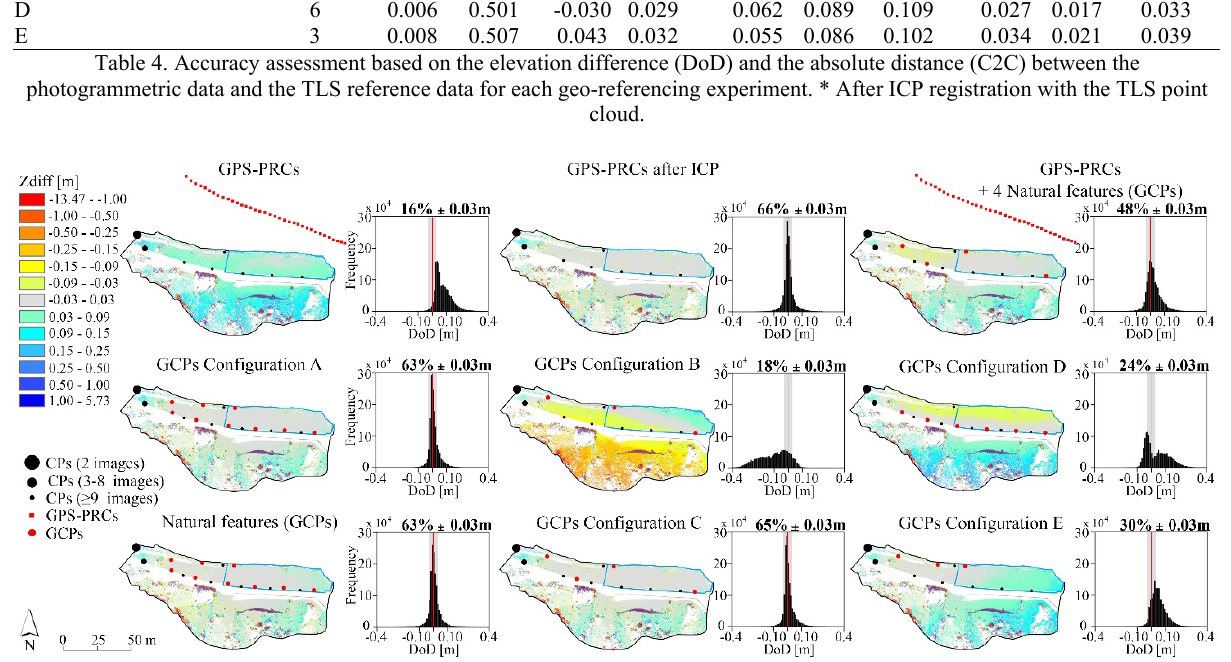
Figure 4. The spatial distribution of the elevation differences (DoD) between TLS data and each photogrammetric DEM obtained by processing the images with different georeferencing methods. The frequency distribution histograms extracted from the DoDs are provided for the entire investigated